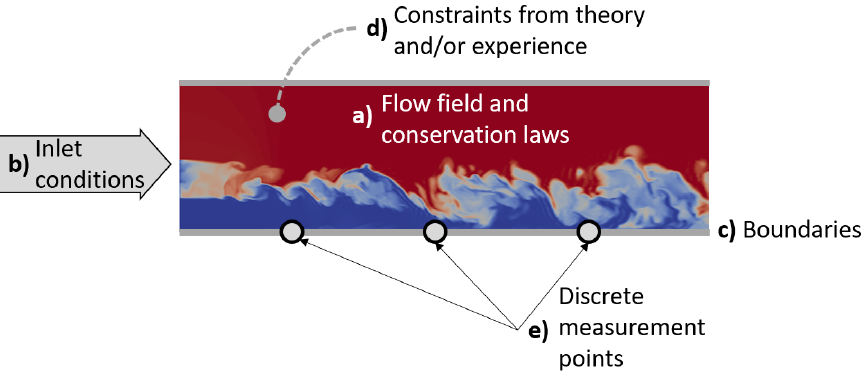
Figure 2. Data and constraints contributing to the definition of the flow field. The picture illustrates a snapshot of the mixing of cold and hot